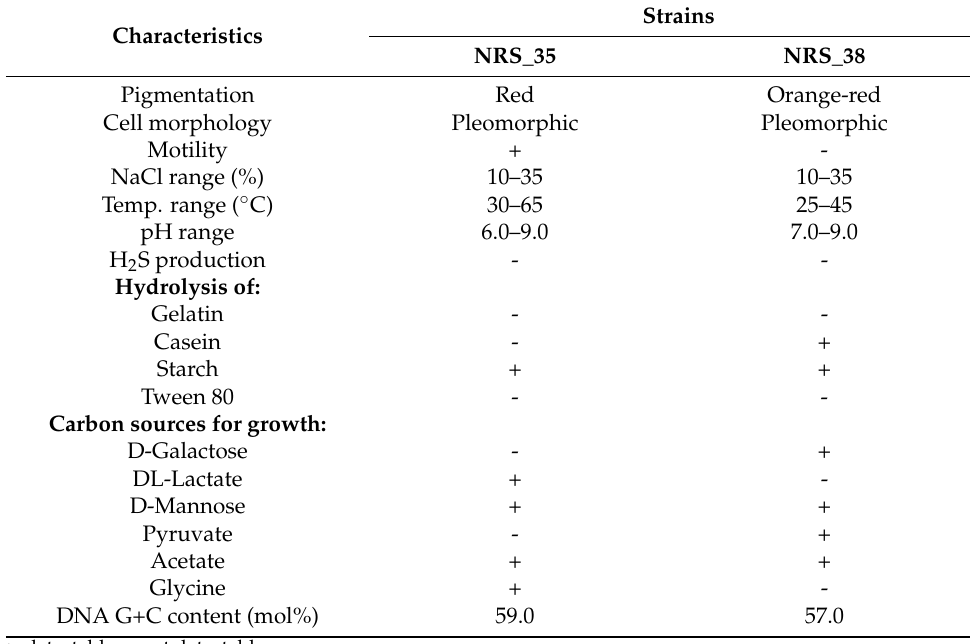
Table 1. Phenotypic characteristics of the studied haloarchaeal